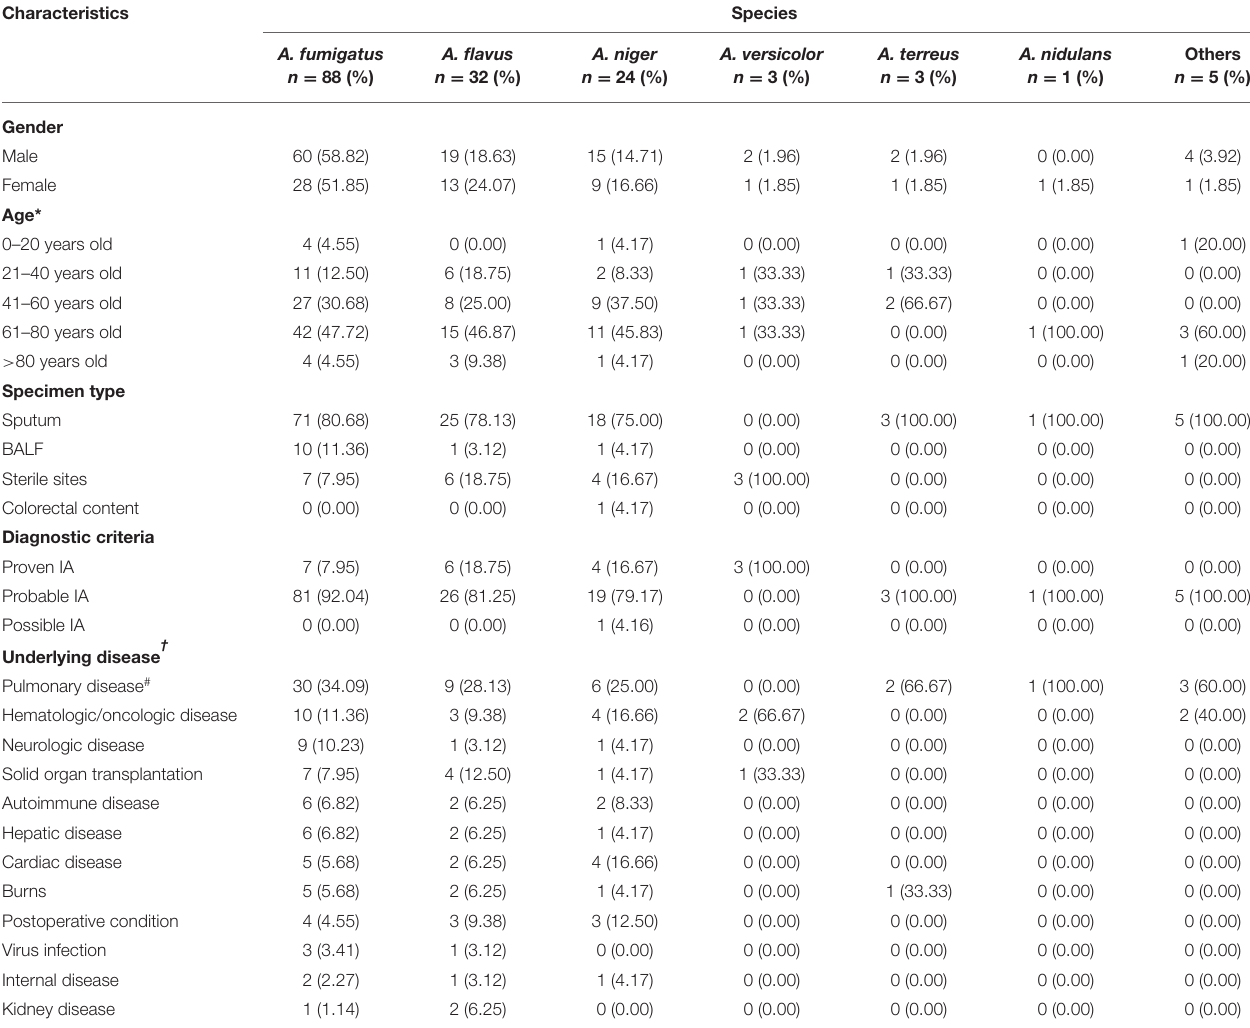
TABLE 1 | Clinical characteristics of the patients with invasive Aspergillu s